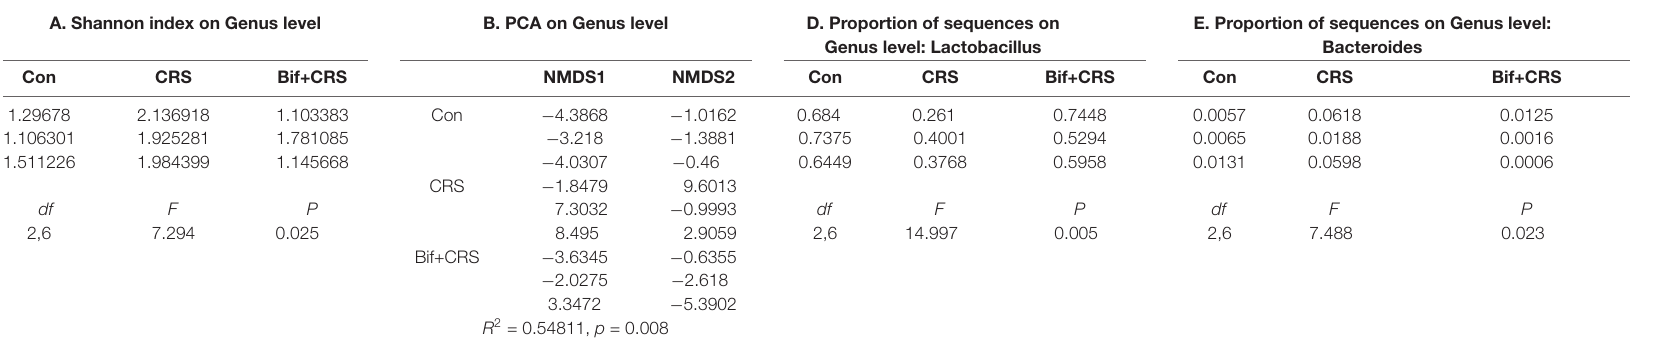
TABLE 4 | B. adolescentis reversed the imbalance of the intestinal microflora induced by CRS at the genus